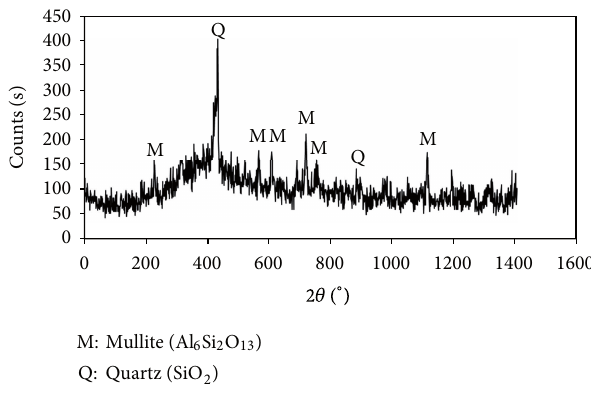
F 22: �-ray di�raction of activated carbon-�y ash composite material.